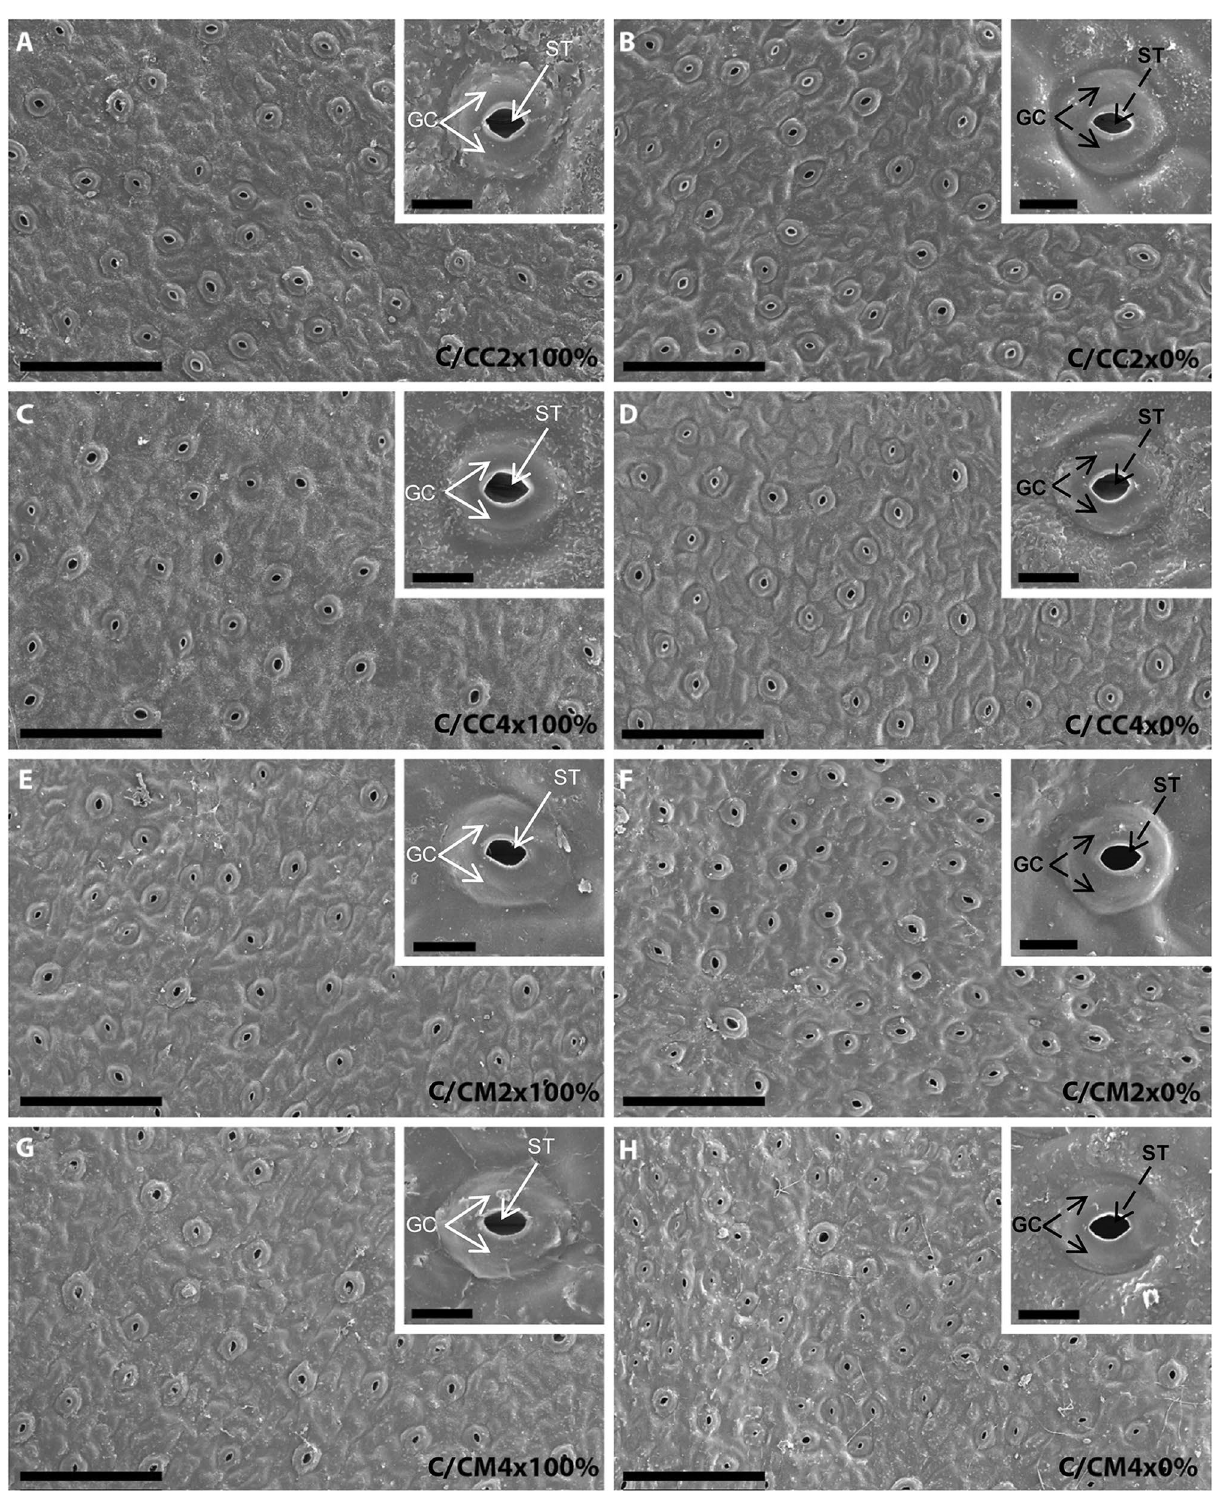
Figure 3. Scanning electron micrographs of abaxial epidermis and stomata in leaves of common clementine scion grafted onto different rootstocks. Abaxial epidermis and stomata of leaves of common clementine scion grafted onto diploid (C/CC2x) and doubled diploid (C/CC4x) Carrizo citrange and diploid (C/CM2x) and doubled diploid (C/CM4x) Citrumelo 4475 rootstocks grown in nutrient reference solution (100%) ( A,C,E,G ) and without nutrient solution (0%) ( B,D,F,H ) for 210 days. Scale bars (10 µm) are indicated at the bottom left for each image. The significant values between rootstock ploidy level of scion/rootstock combinations and treatment are shown in black and bold with a black dotted arrow. ST ostiole (stoma), GC guard